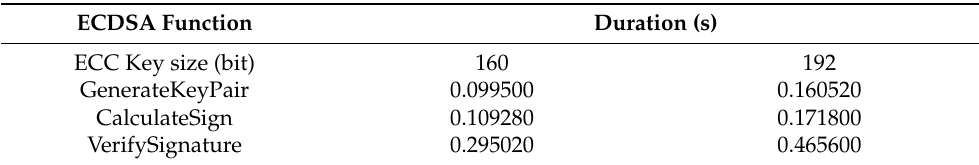
Table 3. Measurements of the executed ECDSA functions based on the RELIC library by the Indus- truino devices.